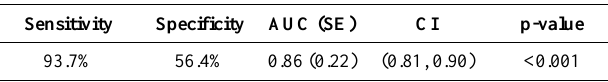
Table 6. Diagnostic tests of the logistic